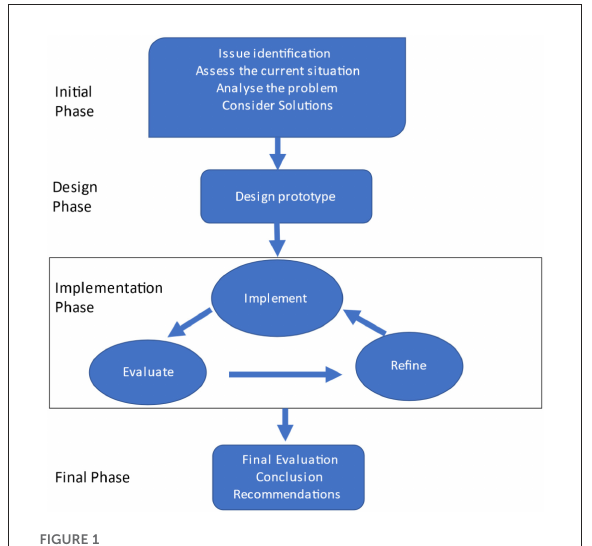
FIGURE1 Design-based research model [adapted from Ferkins et al. (2009b), Jen et al.